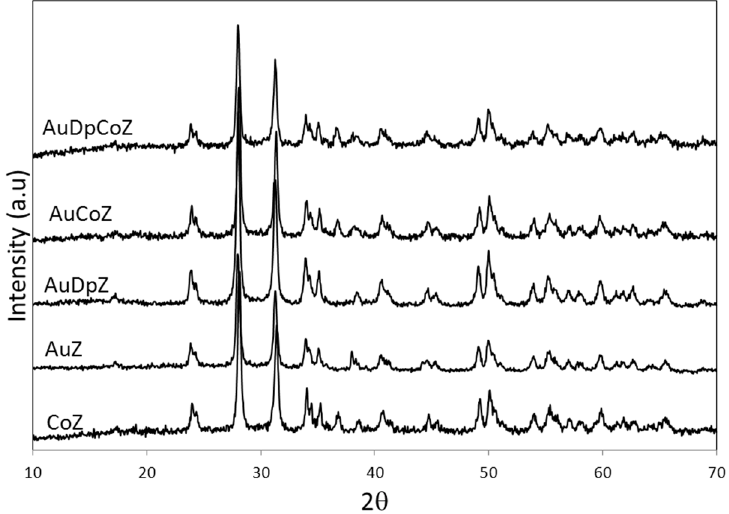
Figure 2. X -ray diffraction patterns of catalysts supported on monoclinic zirconia (Z).